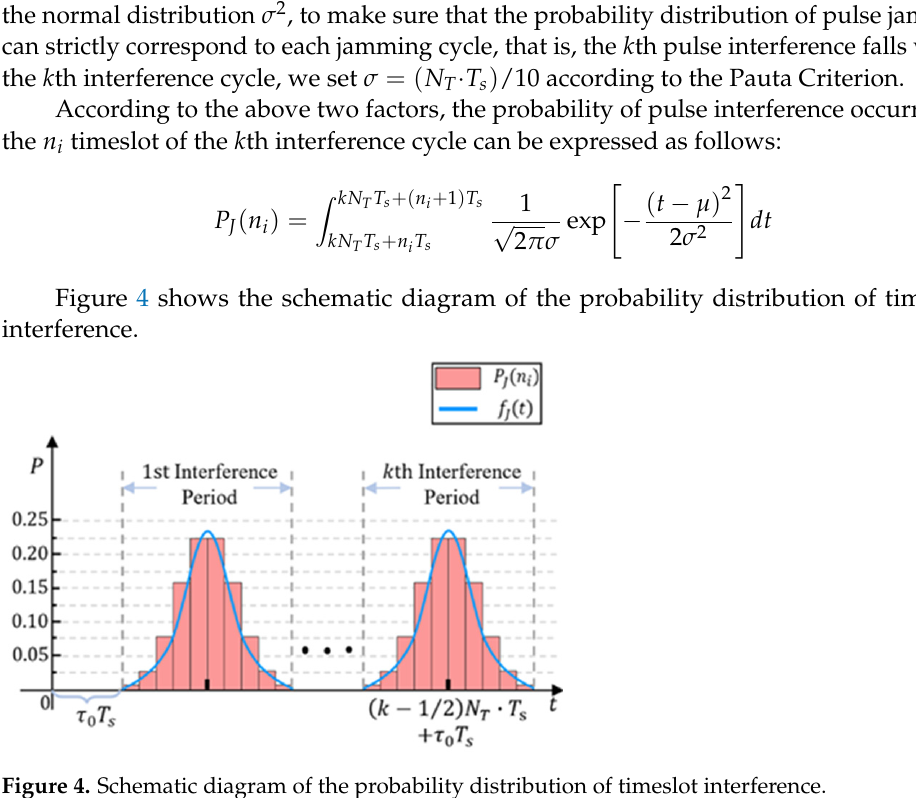
Figure 5. Schematic diagram comparing the CRJ between continuous transmission (CT), the TDAA [11], and the STAA. In conclusion, the comparison between the collision rate and average cycle return of the three algorithms shows that the STAA has good anti-interference performance and anti-interference transmission performance in this situation.